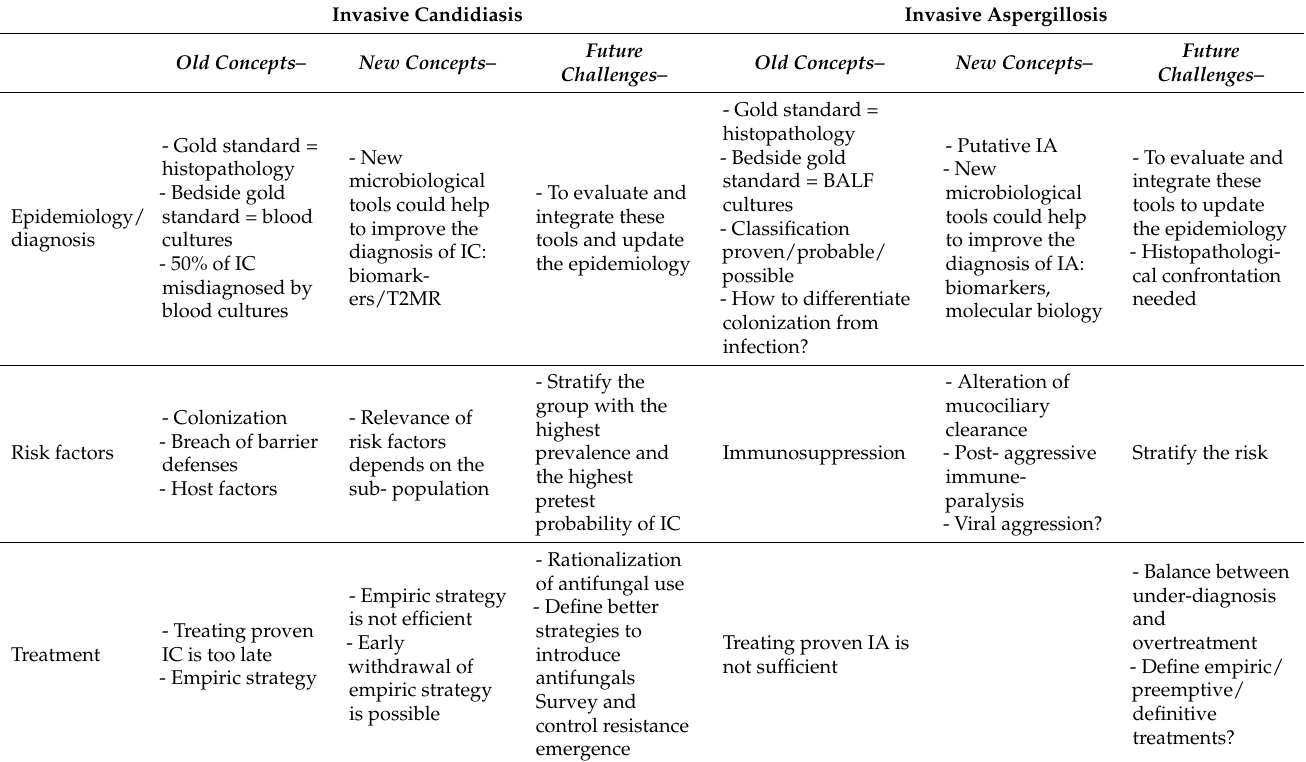
Table 1. Common pitfalls and challenges of invasive candidiasis and invasive aspergillosis in ICU